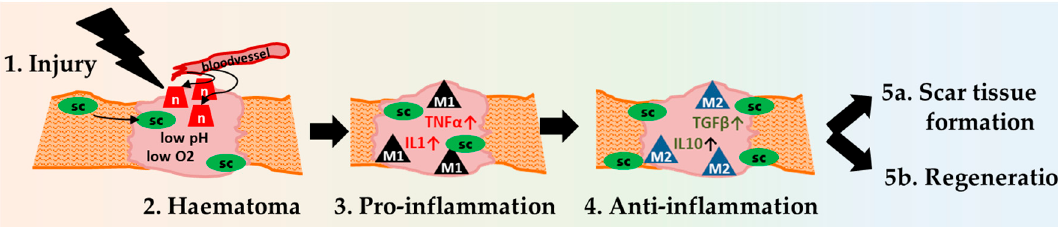
Figure 2. An overview of skeletal muscle regeneration. After an initial trauma, neutrophils (n) and satellite cells (sc) are recruited to the muscle haematoma. Within the haematoma, the pH decreases and the oxygen supply ceases. In the following phase, macrophages (M1) follow and levels of pro-inflammatory cytokine such as TNF α and IL1 increase. In the subsequent anti-inflammatory phase, TGF β and IL10 are increased, and different sub-populations of macrophages (M2) are active. Finally, healing ends in successful regeneration or in a dysfunctional scar tissue.